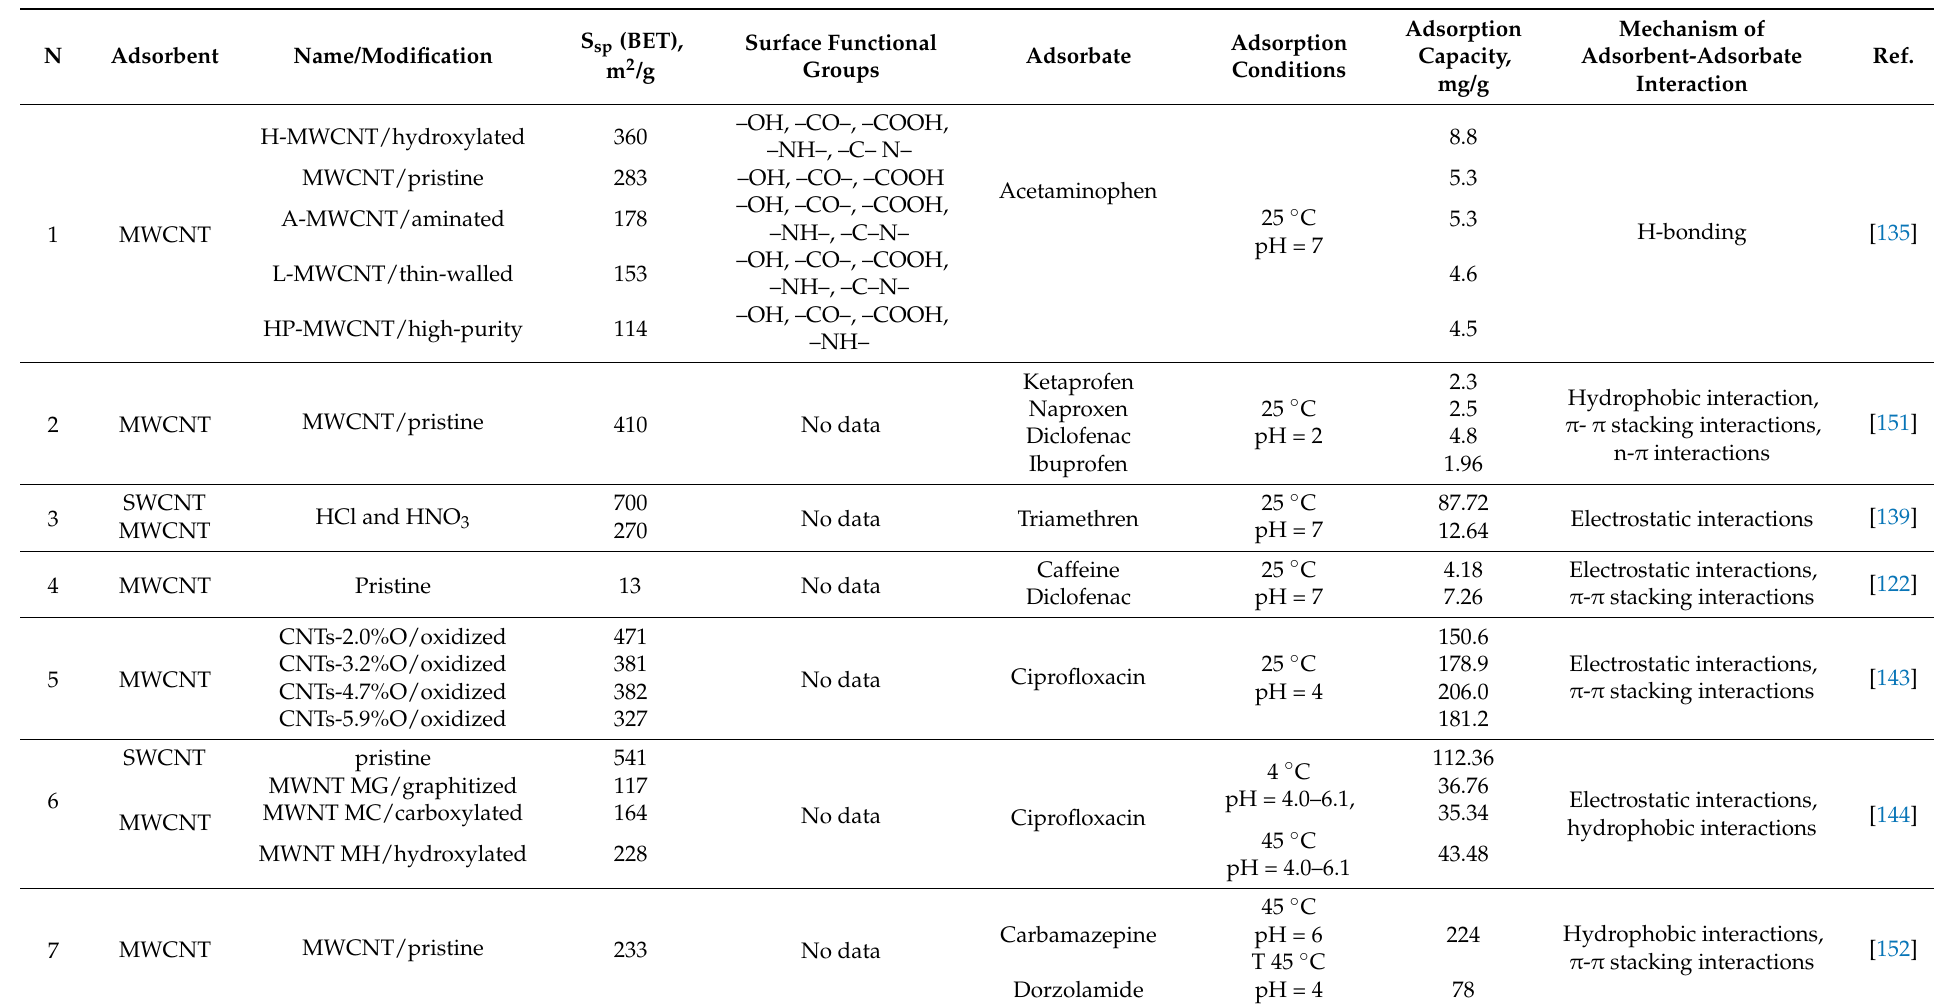
Table 1. Surface characteristics, adsorption capacity and mechanism of adsorption on carbon nanotubes for various